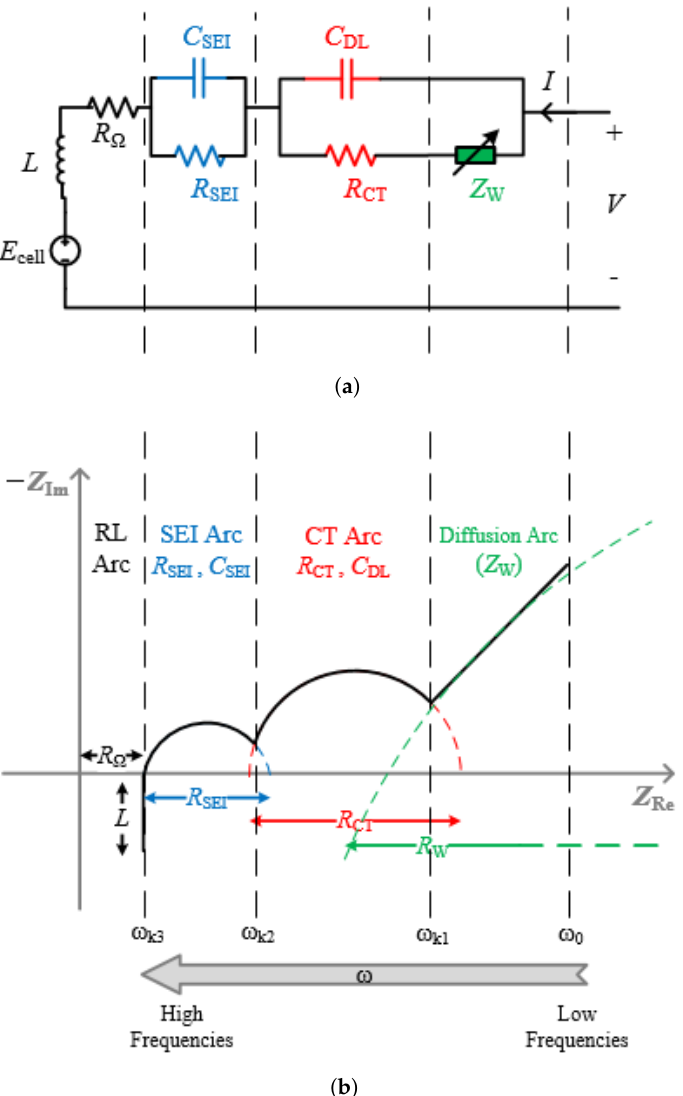
Figure 1. AR-ECM and related impedance spectrum. ( a ) Adaptive Randles equivalent circuit model (AR-ECM). ( b ) Impedance spectrum (Nyquist